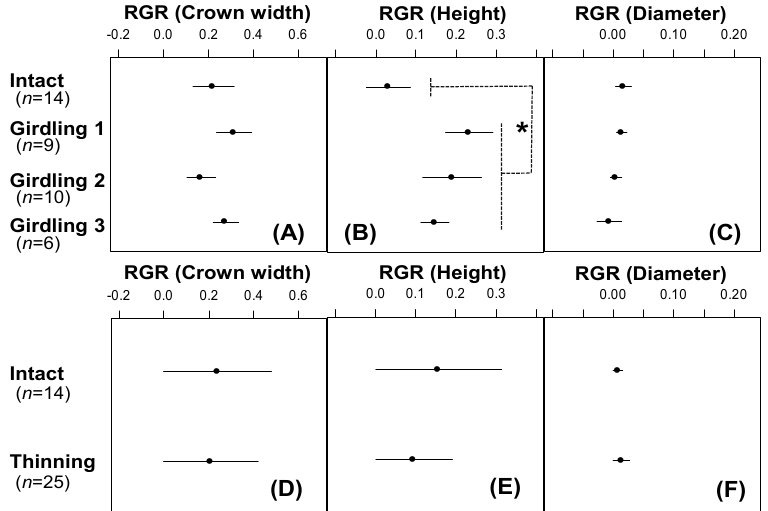
Figure 2. Effects of girdling ( A – C ) and thinning ( D – F ) on the relative growth rates of crown width, height and diameter. In each panel, changes in size are shown for each class from 2017 to 2021. The asterisk within the panel indicates a statistical significance.